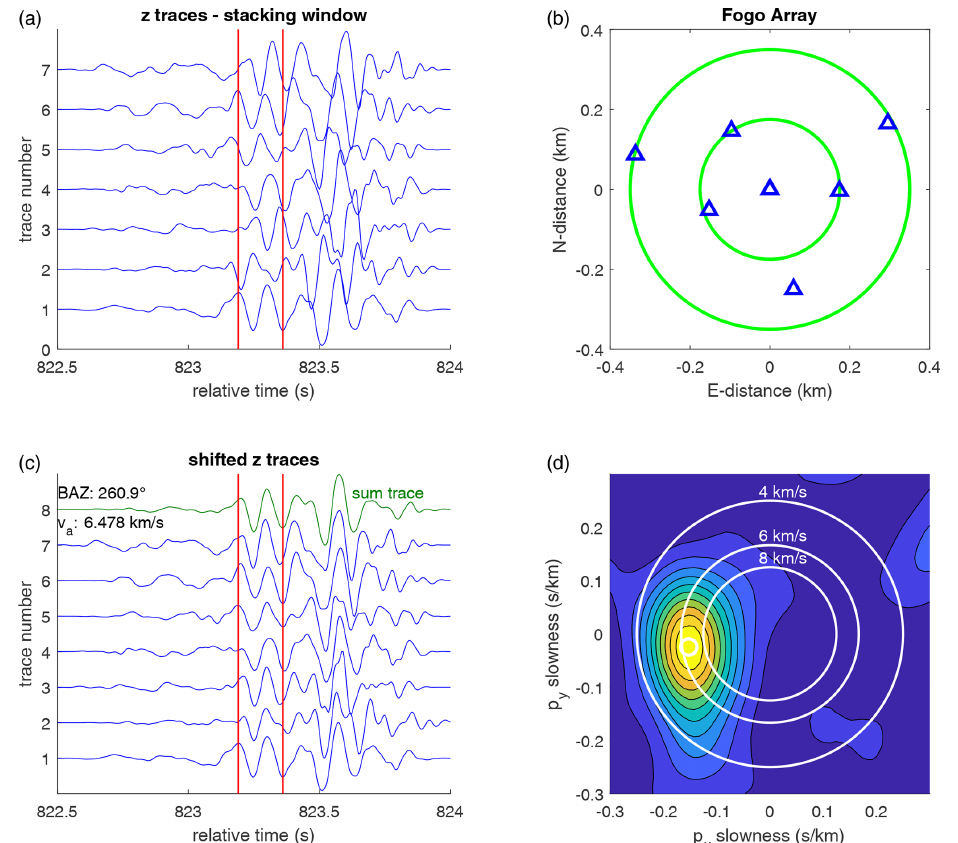
Figure 2. Example of the array analysis applied to an event of the seismic crisis (2 August 2016, 01:13 (UTC)). (a) Record section before shifting and stacking. Traces of the seven array stations are filtered between 1 and 18Hz. The time window has a length of 2.5s; the smaller stacking window is marked in red. (b) The configuration of the seismic array. (c) Traces after shifting and stacking. The sum trace is marked in green. (d) Time-domain energy